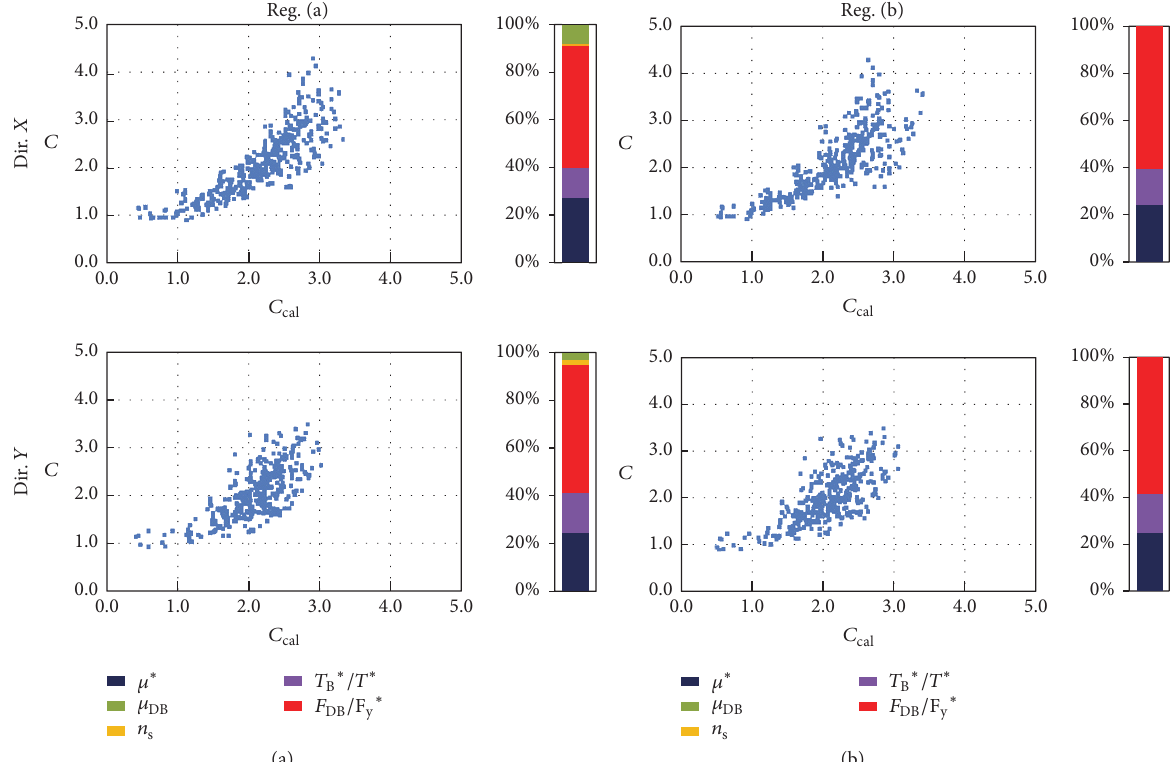
Figure 14: Regression analysis between the correction factors 𝐶 and 𝐶